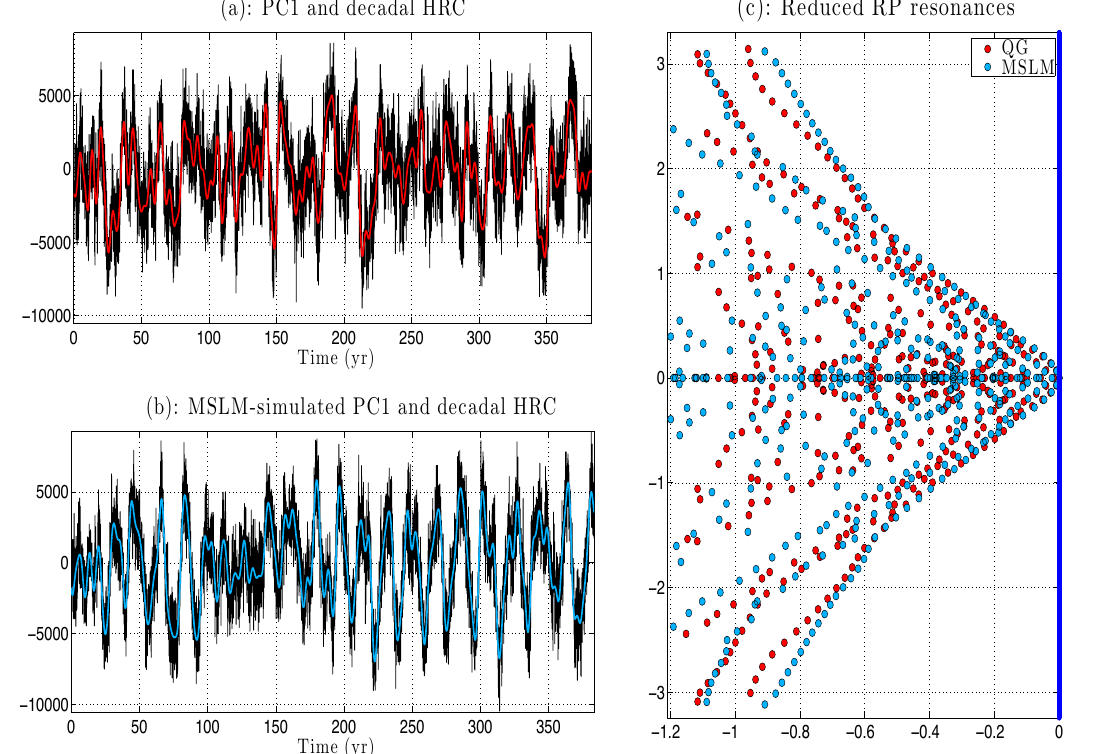
Figure 7. Decadal harmonic reconstruction component (HRC) and its reduced RP resonances for PC1: quasi-geostrophic (QG) model and multilayer Stuart-Landau model (MSLM). ( a , b ) show the sum of the first four HRCs on PC1 for the upper-layer stream function anomalies as simulated from the QG model (red curve) and its DAH-MSLM emulator (blue curve). In both panels, the PC1 is shown in black: in ( b ), PC1 is obtained after simulation of the DAH-MSLM emulator, whereas in ( a ), PC1 is obtained from simulation of the QG model. The HRCs are computed according to (23) in Section 4.2.2 below, from the corresponding simulated data. ( c ) shows the corresponding reduced RP resonances (see Appendix B) as estimated from HRCs shown in ( a , b ); colors match across panels ( a–c